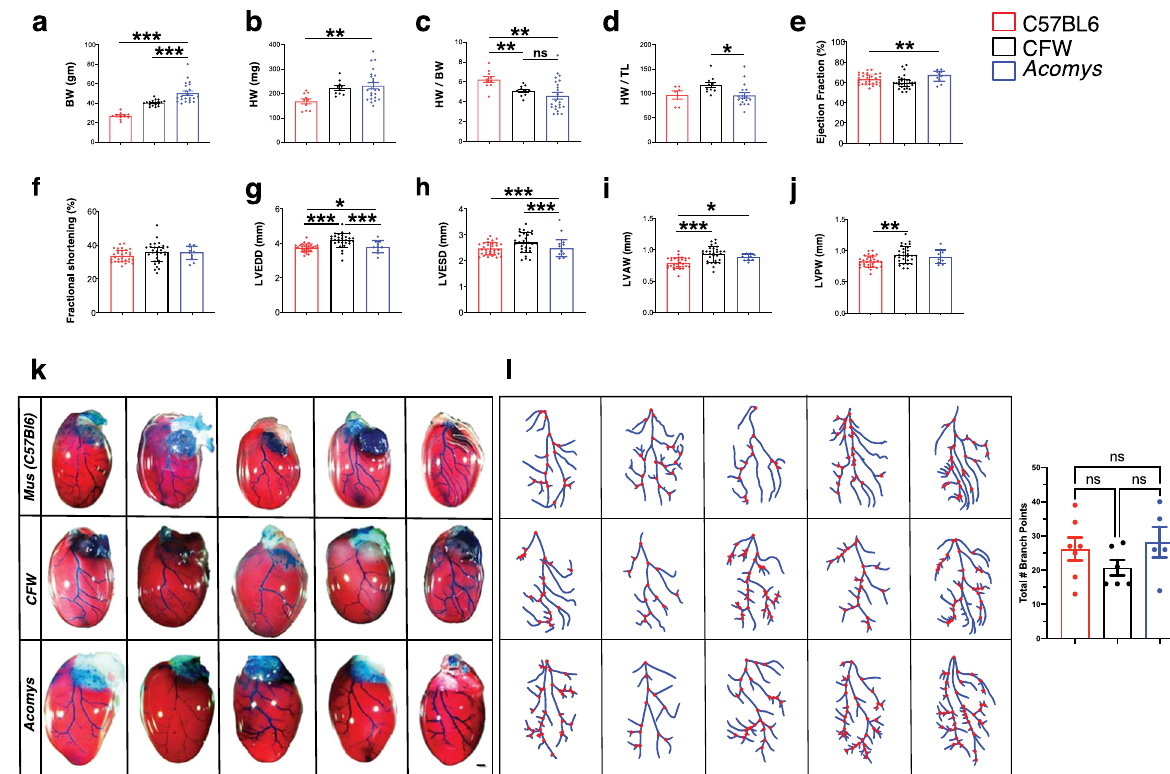
Fig. 1 Characteristics of Acomys heart physiology and anatomy at baseline. a – j Measures of body weight (BW) and heart weight in C57BL6- Mus ( N = 10), CFW- Mus ( N = 19), and Acomys ( N = 22). Analyses demonstrate comparable heart weight across species when normalized by body weight (BW) and tibia length (TL) (values are means ± S.E.M, * P < 0.05, ** P < 0.01, and *** P < 0.001 by one-way ANOVA and Dunnett correction with Acomys as control). Ejection fraction ( F = 4.1, * P < 0.05) ( e ), fractional shortening ( F = 0.96, P > 0.05) ( f ), left ventricular end- diastolic diameter (LVEDD) ( F = 14.8, ** P < 0.01) ( g ), left ventricular end-systolic diameter (LVESD) ( F = 4.6) ( h ), left ventricular anterior wall (LVAW) ( F = 14.9, * P < 0.05) ( i ), left ventricular posterior wall (LVPW) ( F = 6.4) ( j ) ( N = 30 C57BL6- Mus , 10 CFW- Mus and 10 Acomys ). Representative images showing comparable left anterior descending artery coronary anatomy across species using intra-aortic infusion of Batson ’ s 17 polymer mixture and corrosion casting ( N = 5 each group, scale bar = 1 mm) ( k ). Quanti fi cation of coronary branching points of the arterial supply of the left ventricle across species. This analysis shows a comparable number of branching points across species with numerically higher (but not statistically signi fi cant) branching points in C57BL6- Mus and Acomys compared to CFW- Mus ( l ). Detailed statistical output for this fi gure can be found in the Supplementary